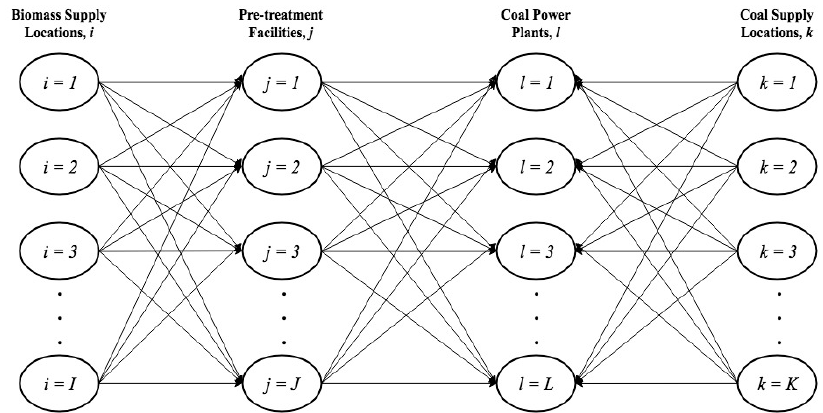
Figure 1. Network Figure 1. Network superstructure.